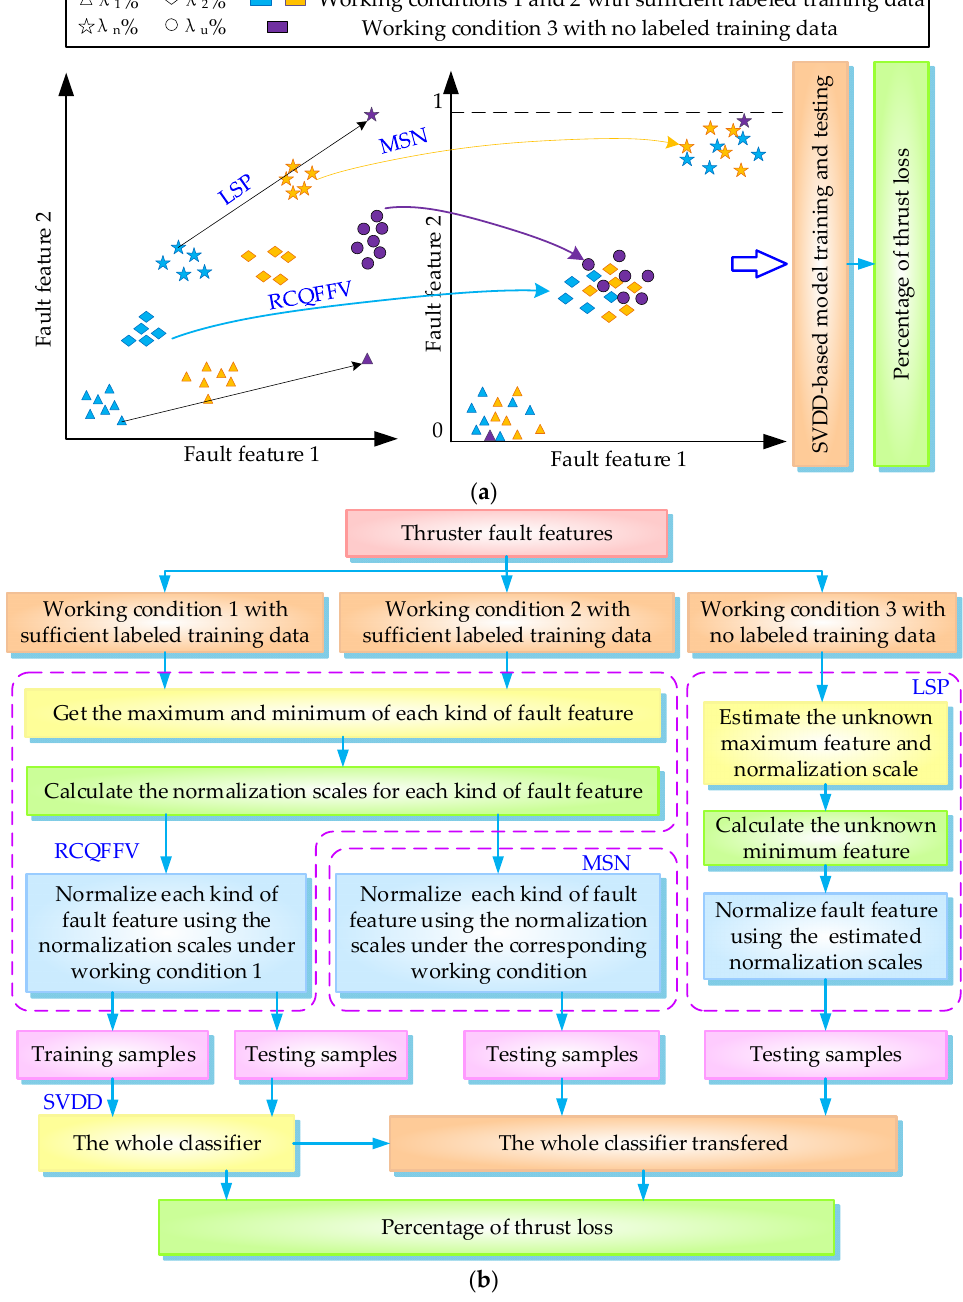
Figure 4. The flow chart of the proposed TSVDD method: ( a ) The schematic diagram; ( b ) The framework diagram.